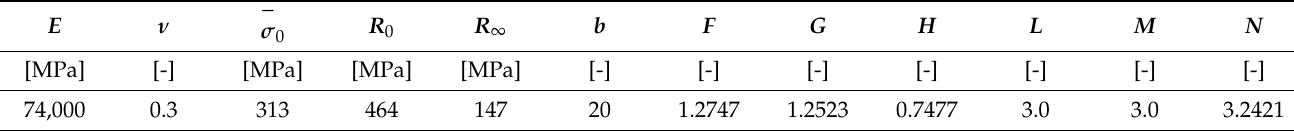
Table 2. Material parameters of EN AW-2017A.